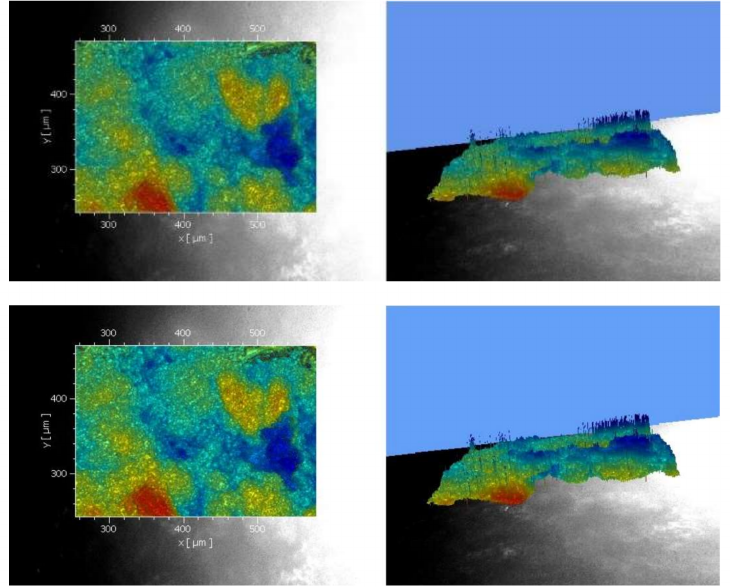
Figure 9. Records of the surface roughness with linear regression, left 2D and right 3D